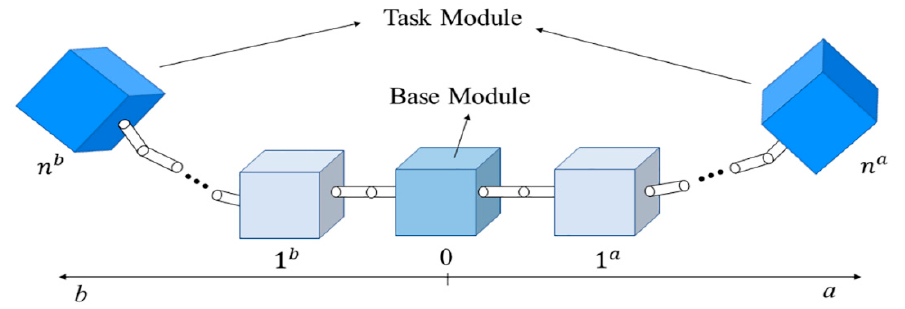
Figure 4. Base module and task module for a particular task.